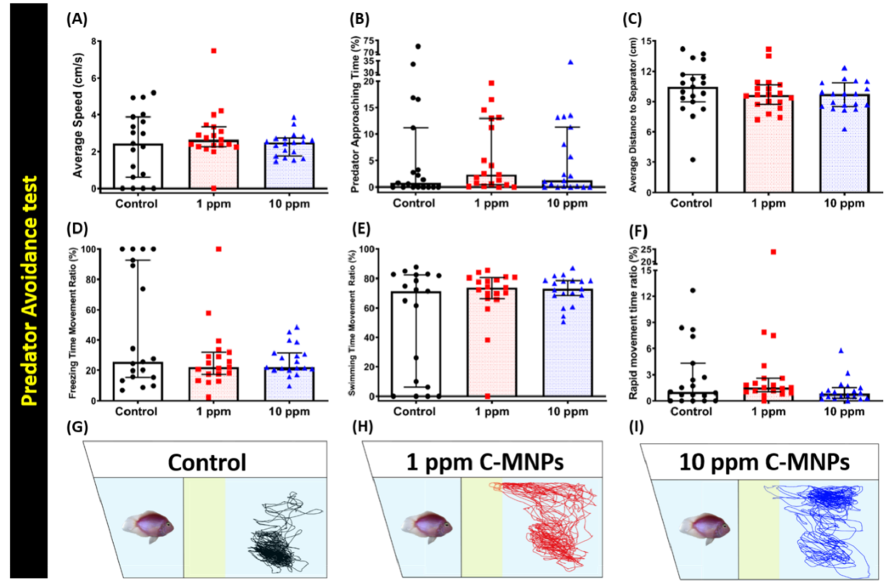
Figure 4. Avoidance behavior endpoint comparisons between control, 1 ppm, and 10 ppm C-MNPs-exposed zebrafish groups after two weeks of exposure. ( A ) Average speed, ( B ) predator approaching time, ( C ) average distance to the separator, ( D ) freezing time movement ratio, ( E ) swimming time movement ratio,and ( F ) rapid movement time ratio were analyzed. The 5 min locomotor trajectories for the control, 1 ppm, and 10 ppm C-MNPs-exposed fish in the predator avoidance test were presented in ( G–I ). The data are expressed as the median with interquartile range and were analyzed by the Kruskal-Wallis test with Dunn’s multiple comparisons test as a follow-up test ( n = 19 for the control group, n = 20 for 1 ppm C-MNPs-exposed group, and = 20 for 10 ppm C-MNPs-exposed group).